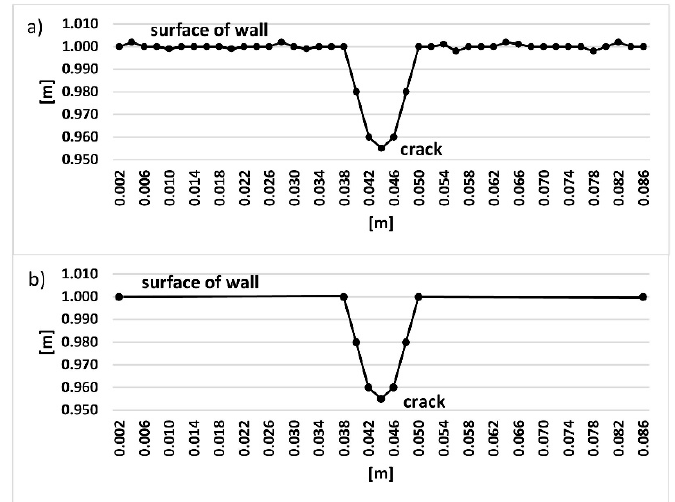
Figure 3. Results of the reduction process in measuring strip ( a ) before reduction, ( b ) after